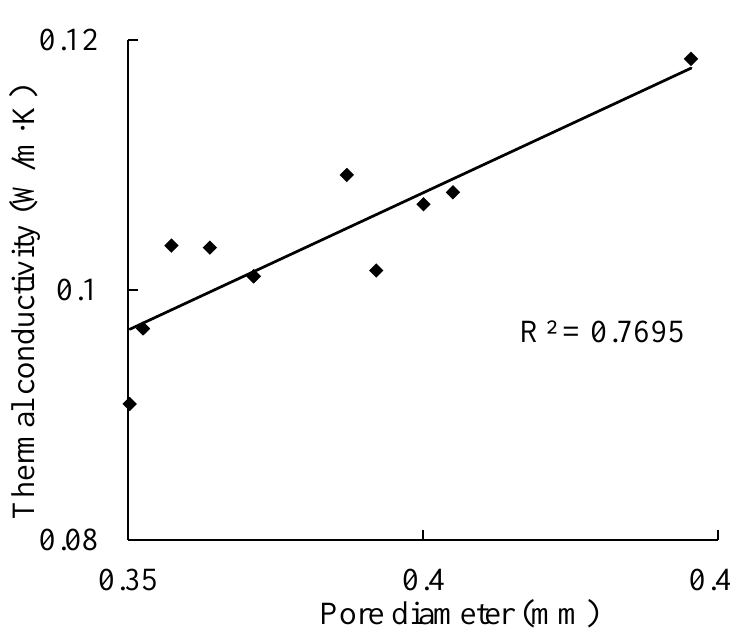
Figure 11. Relationship between pore diameter and thermal conductivity.